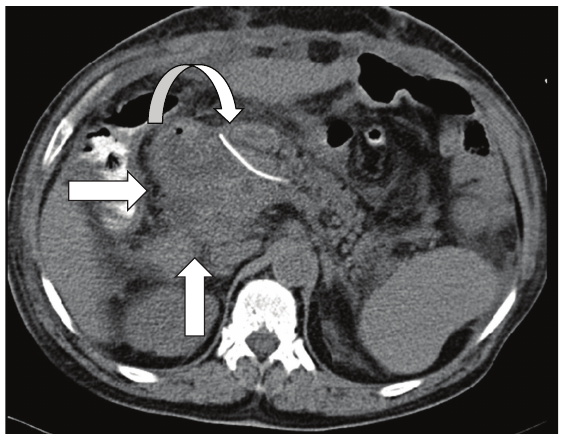
Figure 1: CT scan carried out on the 9th postoperative day follow- ing pancreaticoduodenectomy reveal peripancreaticojejunal anas- tomosis collection (straight arrows). This grade B pancreatic fistula was successfully managed by CT guided aspiration. The internal pancreatic duct stent is also seen (curved